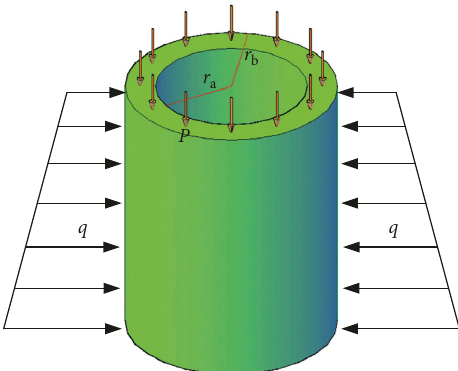
Figure 2: Axisymmetric calculation model of the thick-wall